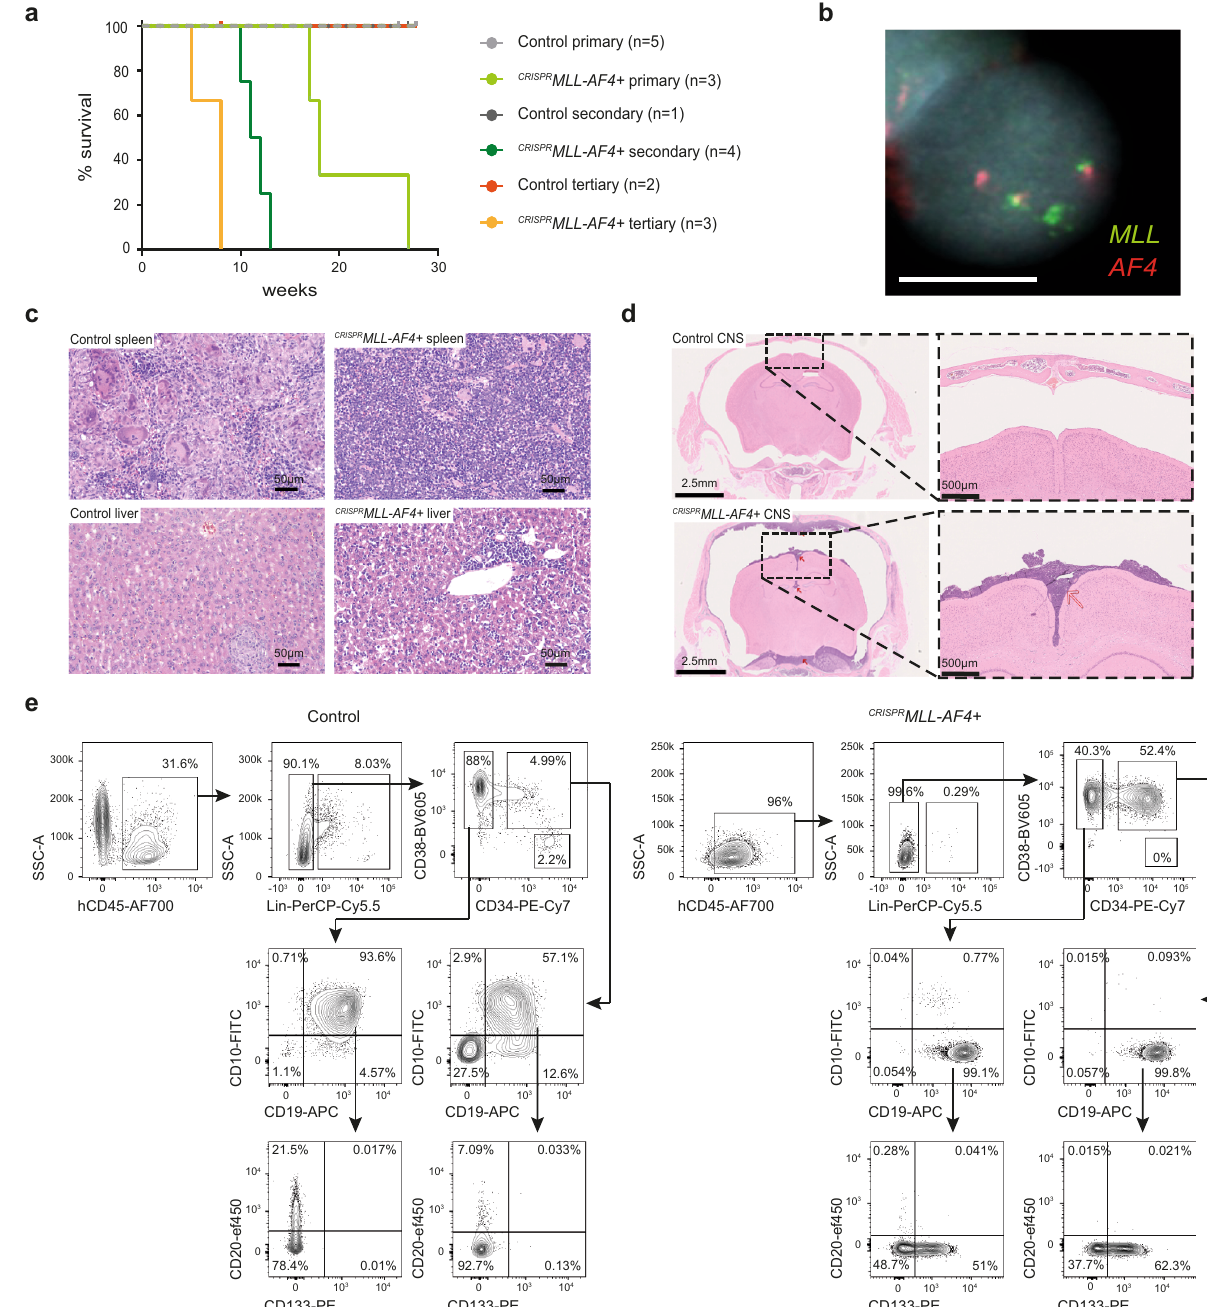
Fig. 3 CRISPR MLL-AF4 + cells give rise to a B-ALL in vivo that recapitulates many key features of infant-ALL. a Leukemia-free survival for primary ( CRISPR MLL-AF4 + n = 3: donors 1 and 2; control n = 5: donors 1, 2, 3, and 6), secondary ( CRISPR MLL-AF4 + n = 4: donors 1 and 2; control n = 1: donor 1) and tertiary ( CRISPR MLL-AF4 + n = 3: donors 1 and 2; control n = 2: donor 1) recipient mice. Mice culled with no signs of leukemia (see “ Methods ” ) are censored (shown as a tick above the line). Latency signi fi cantly reduced for secondary ( p = 0.018) and tertiary ( p = 0.03) CRISPR MLL-AF4 + compared to primary CRISPR MLL-AF4 + (log-rank (Mantel – Cox) test). Source data are provided as a Source Data fi le. b Dual FISH ( MLL probe = green; AF4 probe = red) showing heterozygous chromosomal translocation in a CRISPR MLL-AF4 + cell isolated from the spleen of a primary recipient mouse. Representative image of 200 cells analyzed ( n = 3; donor 1 – 2). c Representative H&E staining of spleen and liver from control and CRISPR MLL-AF4 + primary recipient mice ( n = 3; donor 1 – 3). Scale bar = 50 µ m. d Representative H&E staining of control and CRISPR MLL-AF4 + primary recipient mouse heads (scale bar = 2.5 mm; red arrows = regions of concentrated blast cell in fi ltration). High magni fi cation images (scale bar = 500 µ m) highlight striking parameningeal blast cell in fi ltration in CRISPR MLL-AF4 + mice (red arrow) but not control ( n = 4; donor 1 – 2 primary and secondary recipients). e Representative fl ow cytometry plots of viable, single cells in control and CRISPR MLL-AF4 + BM at termination (weeks 17 and 18,